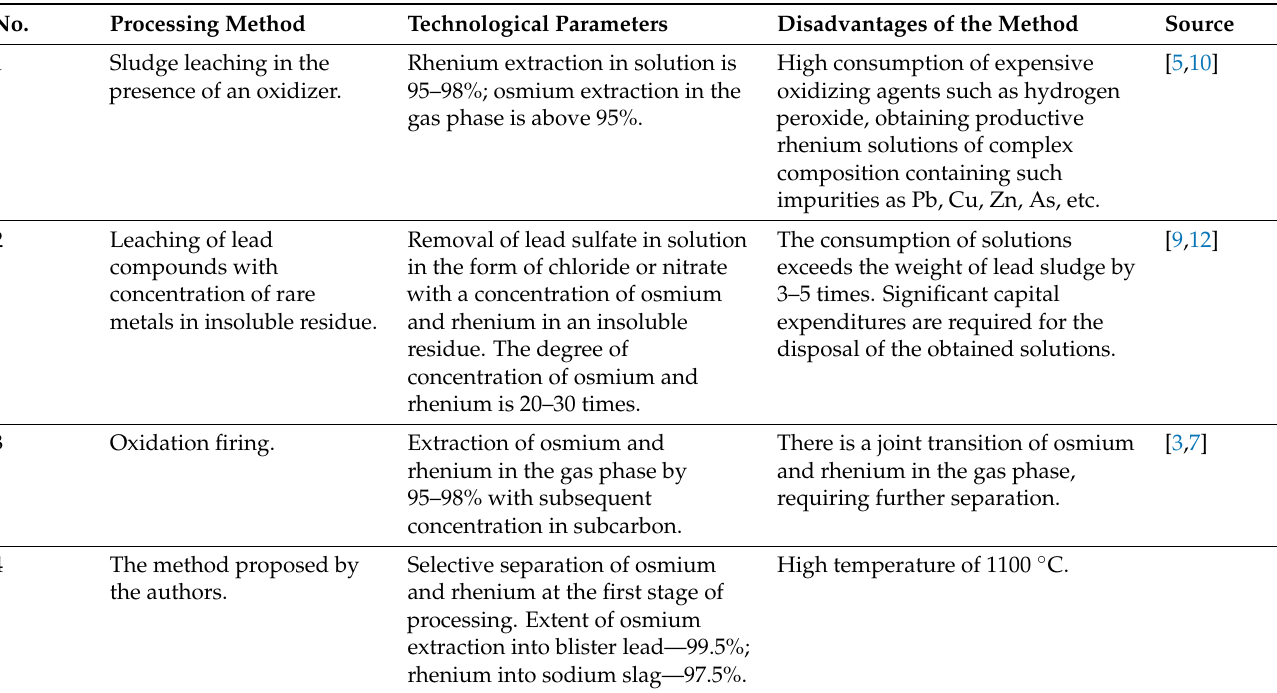
Table 4. Comparative data of technological indicators of rhenium and osmium extraction methods.